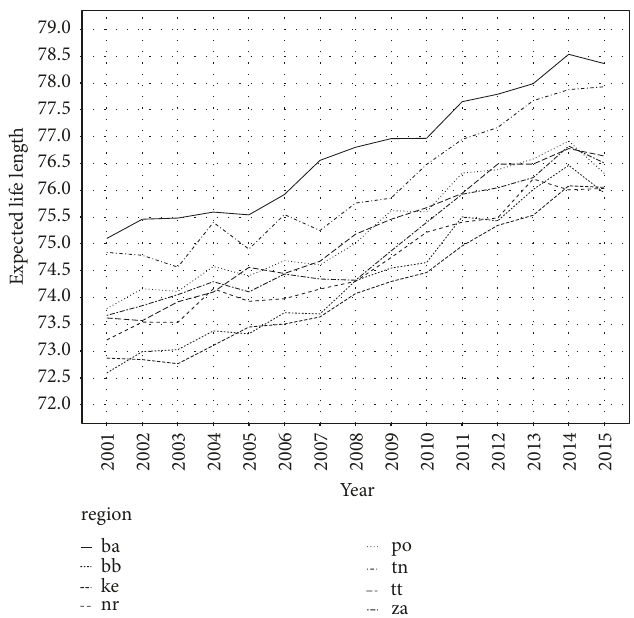
Figure 1: Expected life length in Slovak regions for all causes of